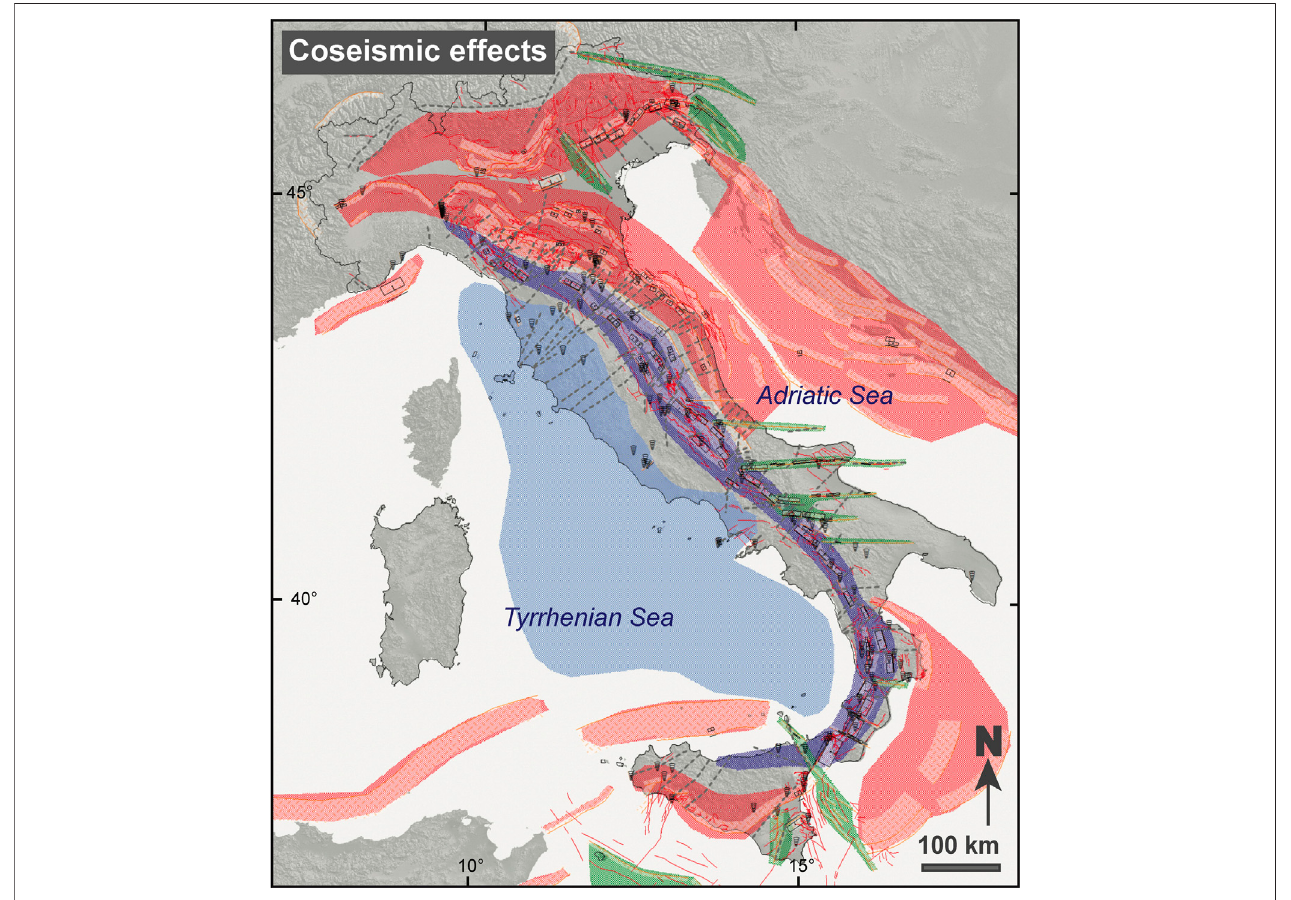
FIGURE 8 | Summary of the testimonies fi led under “ Gas emissions and mud-cone eruptions ” (79 data) and “ H 2 S emissions ” (60 data) from the CFTI5Med catalogue. All data are shown with a 3D spiral symbol.